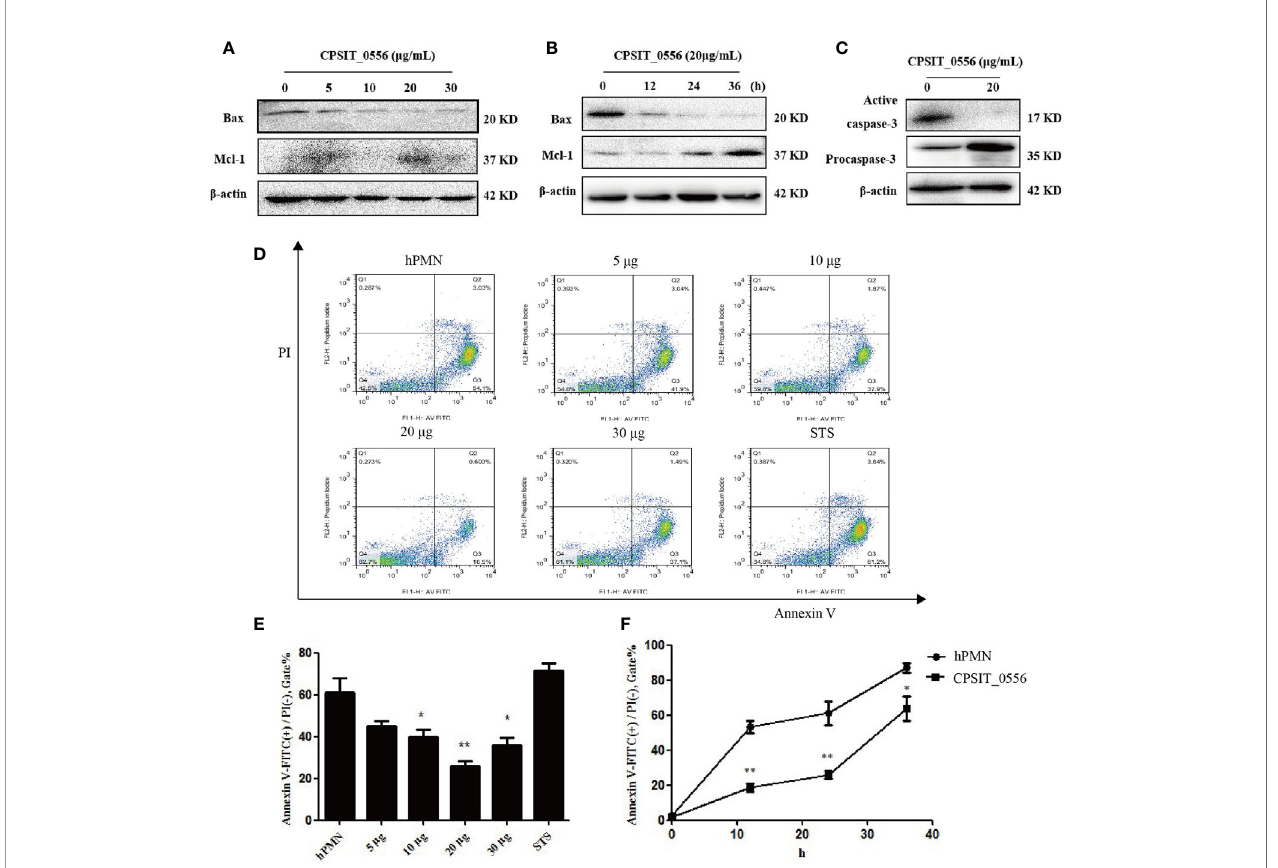
FIGURE 2 | CPSIT_0556 delays spontaneous hPMN apoptosis. (A) CPSIT_0556 stimulated hPMN at different concentrations for 24 h, expressions of Bax and Mcl- 1 were detected by Western blotting. (B) Exposure of hPMN to CPSIT_0556 at different times; expression of Bax and Mcl-1 were detected by Western blotting. (C) Expression of procaspase-3 and active caspase-3 in hPMN with or without CPSIT_0556 for 24 h. (D) Exposure of hPMN to CPSIT_0556 at different concentrations for 24 h, and the apoptosis rate was detected by fl ow cytometry. (E, F) Apoptosis rate of hPMN with or without CPSIT_0556 at different concentrations and at different times. * P < 0.05, ** P <